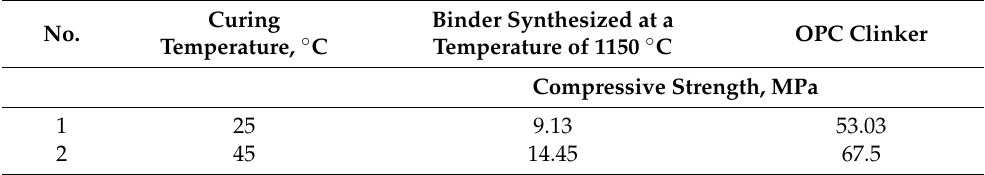
Table 3. Compressive strength of the samples formed from the Karpenai limestone and Saltiskiai